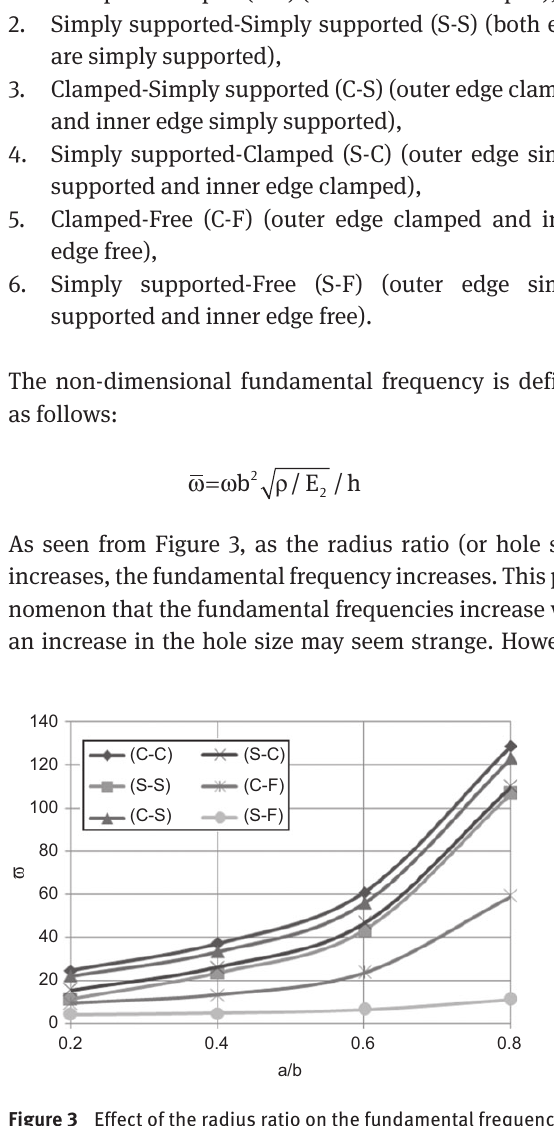
Figure 3 Effect of the radius ratio on the fundamental frequency for laminated annular circular